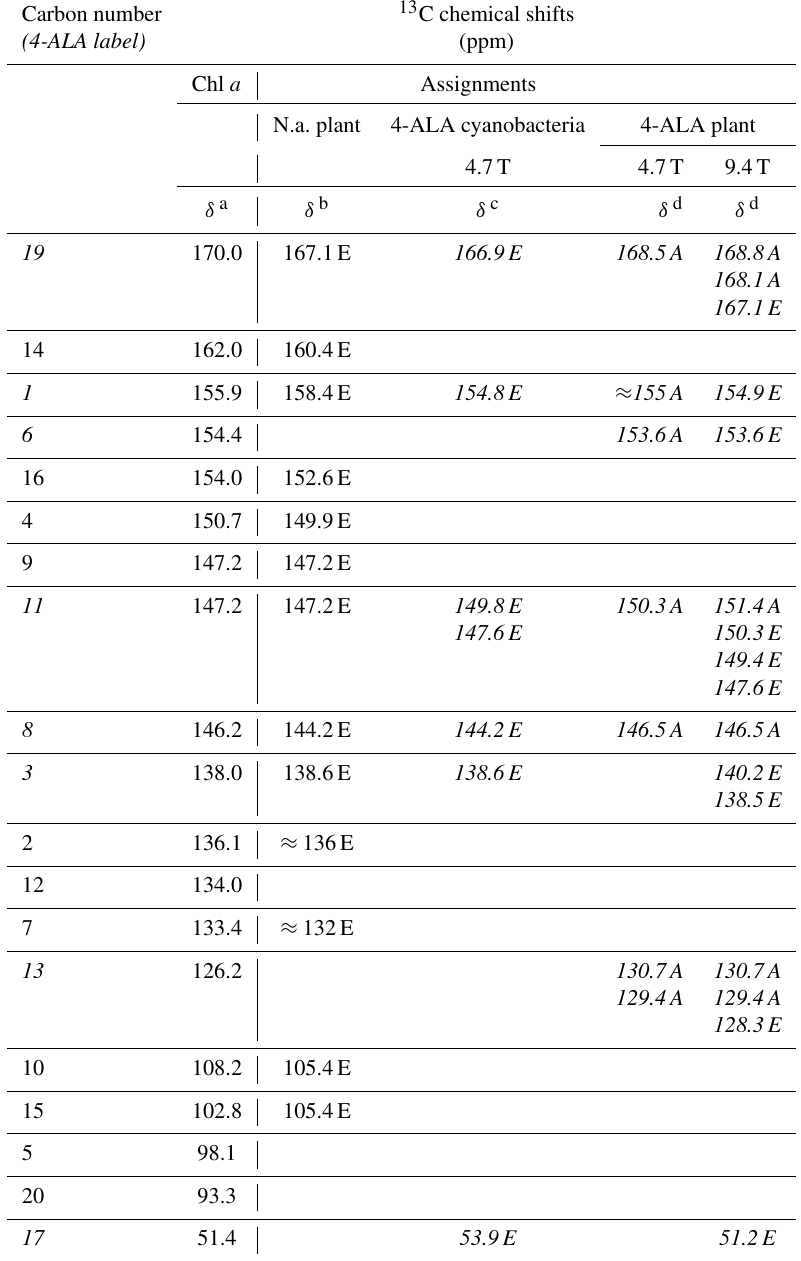
Table 1. 13 C chemical shifts of the photo-CIDNP signals obtained at 4.7 and 9.4Tesla in comparison to literature data. Assignments obtained from 4-ALA-labeled samples are given in italics. See the footnotes below the table for more details. In the reference work, carbons C-9 and C-11 could not be